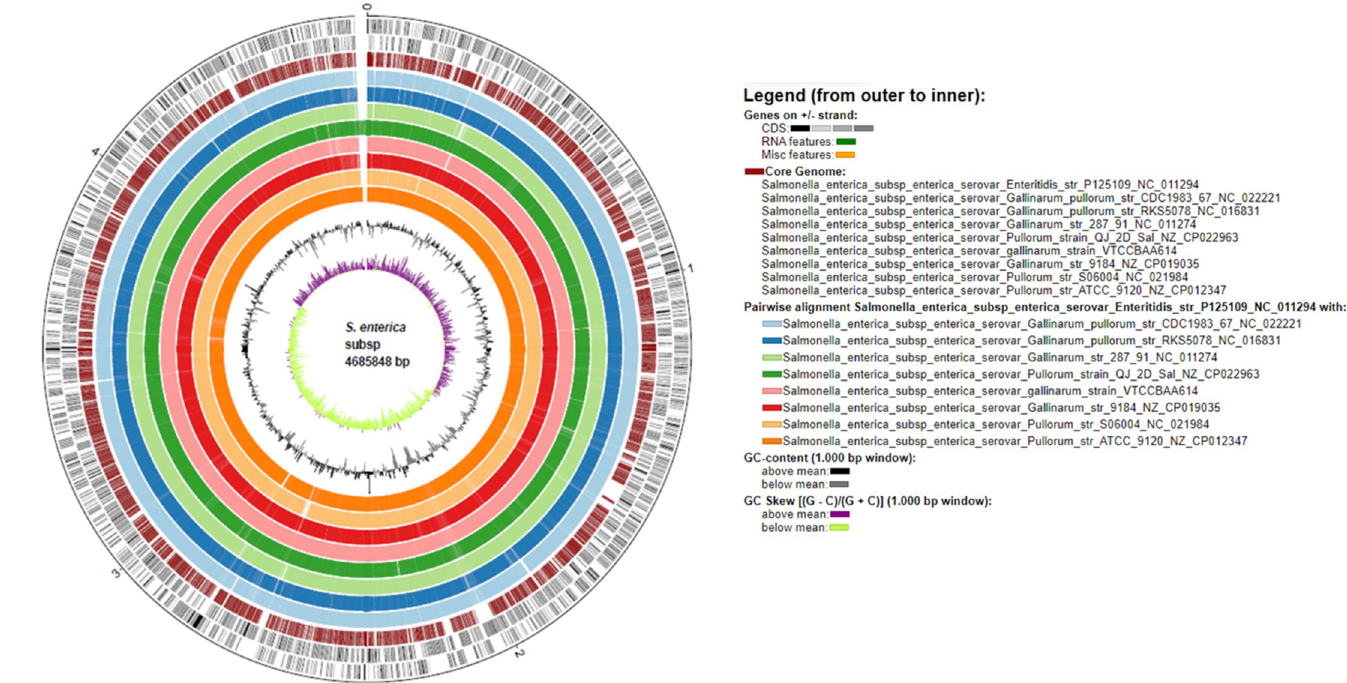
Fig 1. Circular plot genome representation of nine investigated Salmonella strains i . e . a) S . Gallinarum str. 287/91 b) S . Gallinarum str. 9184 b) S . Gallinarum Sal40 strain d) S . Pullorum str. ATCC 9120 e) S . Pullorum str. S06004 f) S . Pullorum QJ-2D-Sal g) S . Gallinarum/Pullorum str. CDC1983-67 and h) S . Gallinarum/Pullorum str. RKS5078 with demonstration of GC content, GC skew and CDS in reference to S . Enteritidis str. P125109.